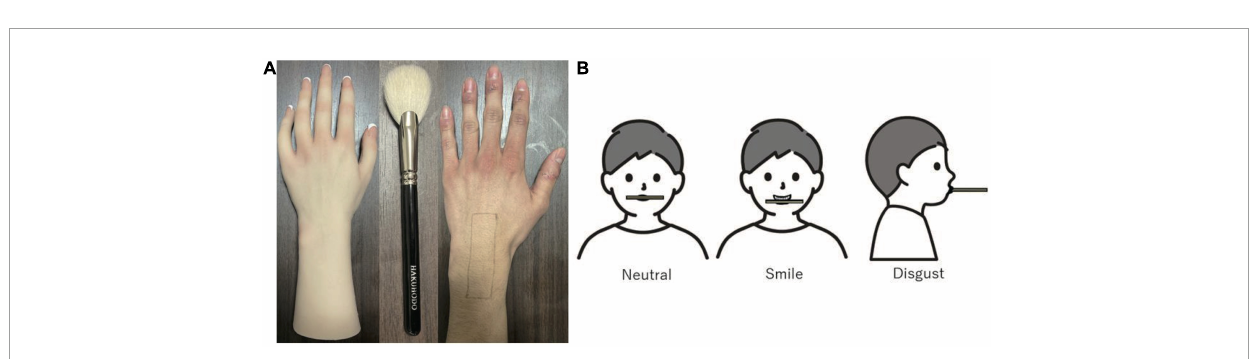
FIGURE2 (A) The fake hand (left) and the brush (middle) used in the experiment, and the area on the real hand for the presentation of tactile stimuli (right). (B) Facial manipulations with a wooden